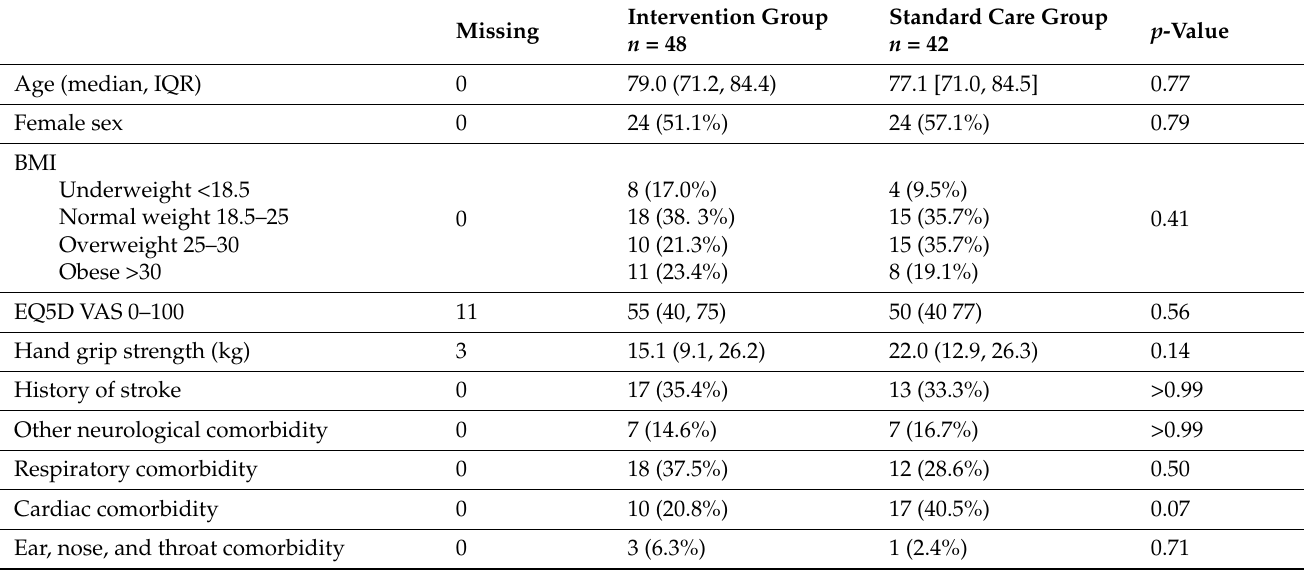
Figure 2. Flowchart for enrolment and inclusion of participants. Baseline characteristics of partici- pants can be seen in Table 1. No systematic differences between participants were found. Table 1. Baseline characteristics of participants.